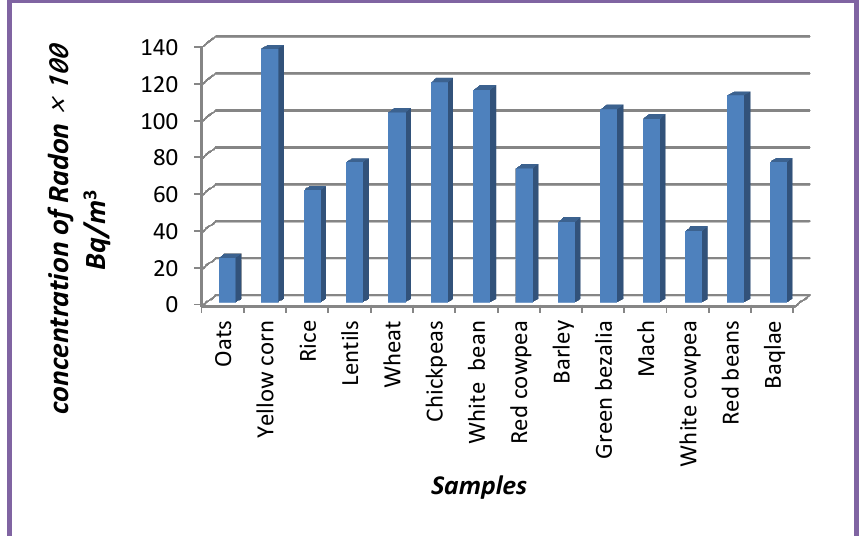
Fig.1: Concentration of radon (Bq / m 3 ) for legumes and grains samples. Fig.